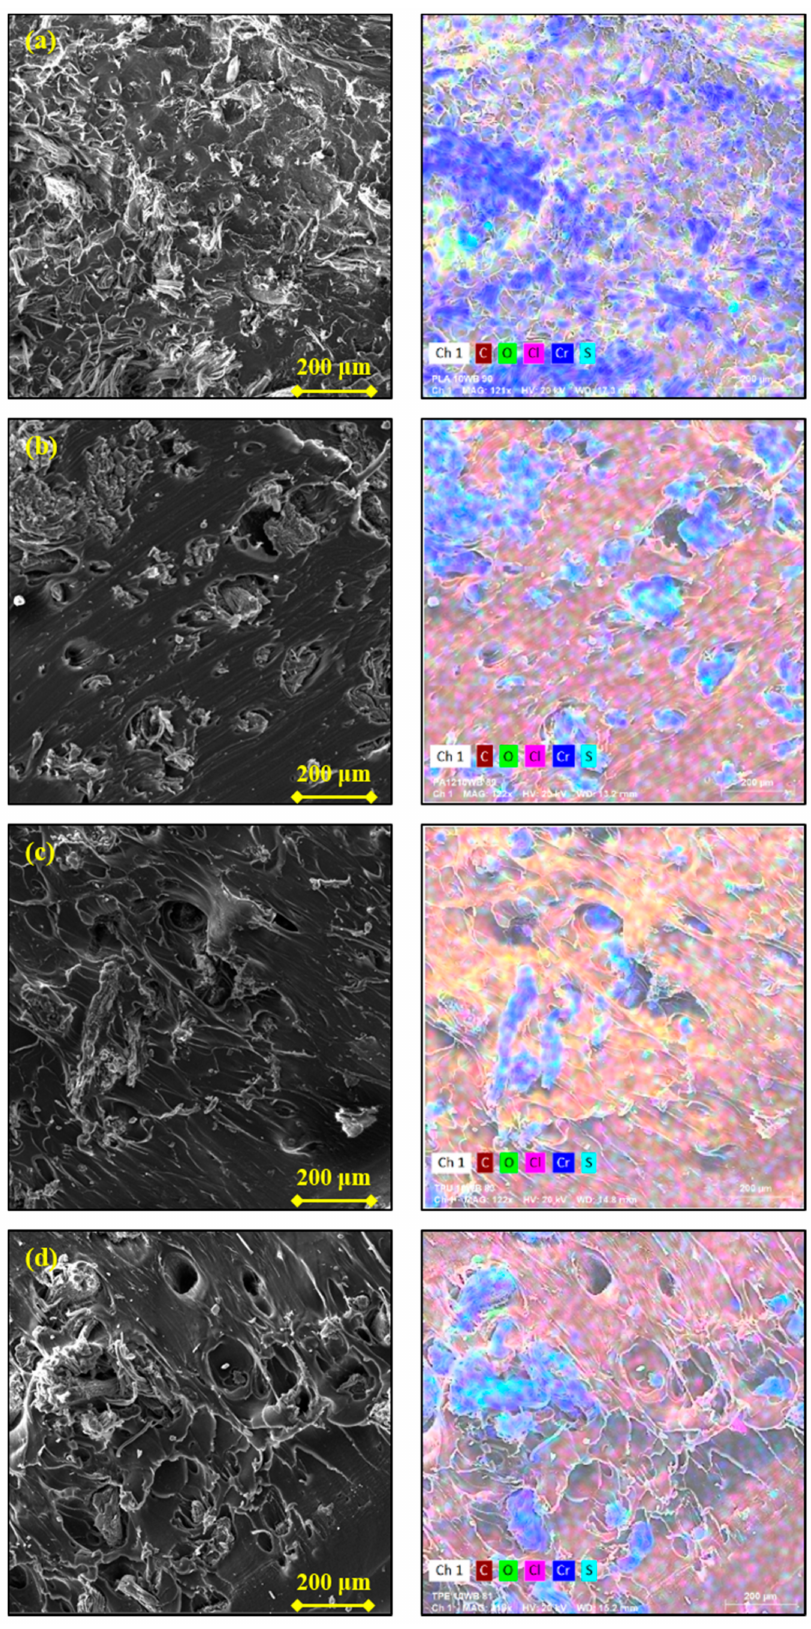
Figure 6. Scanning electron microscope (SEM) images of PLA- ( a ), PA12- ( b ), TPU- ( c ), and TPE-based ( d ) composites taken at low magnification (200 × ) and their corresponding EDS maps on the